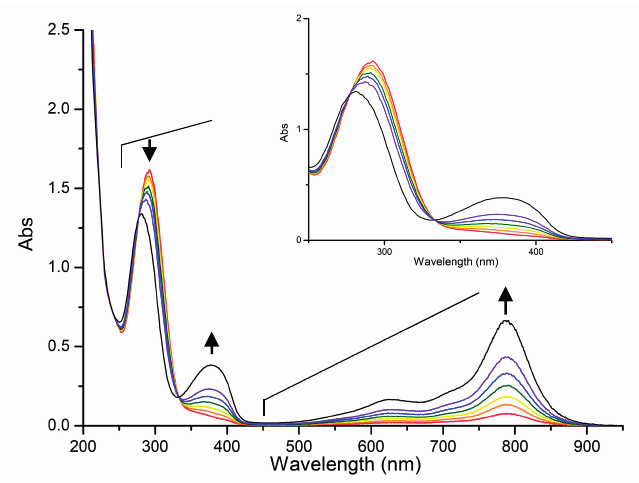
Figure 4. In situ electronic absorption spectra (0.1 M NBu 4 PF 6 in CH 3 CN; room temperature)